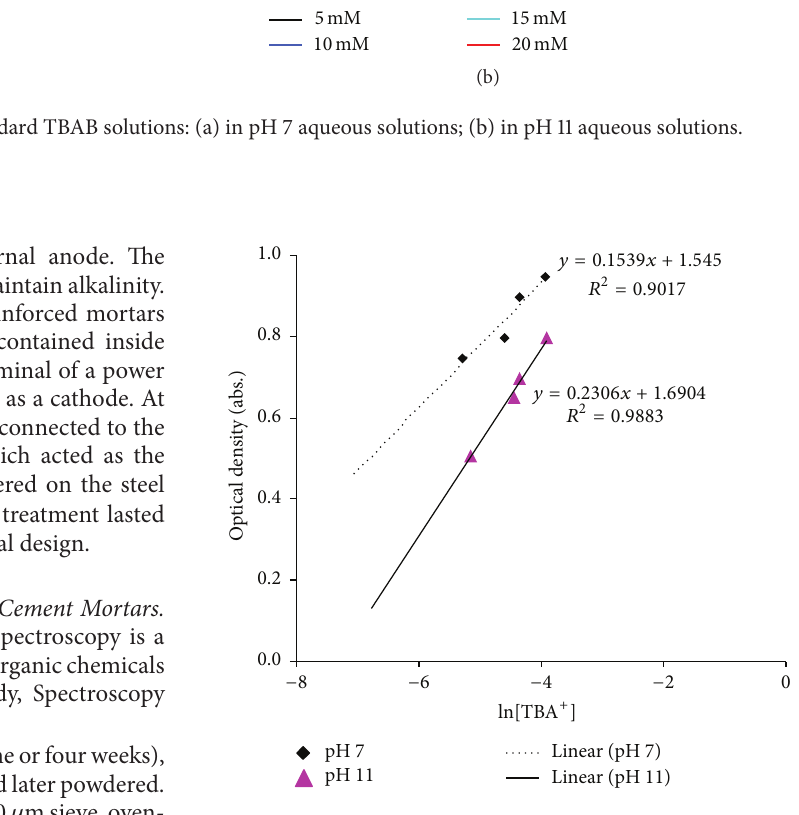
Figure 3: Calibration curve in aqueous TBAB solutions at pH 7 and pH